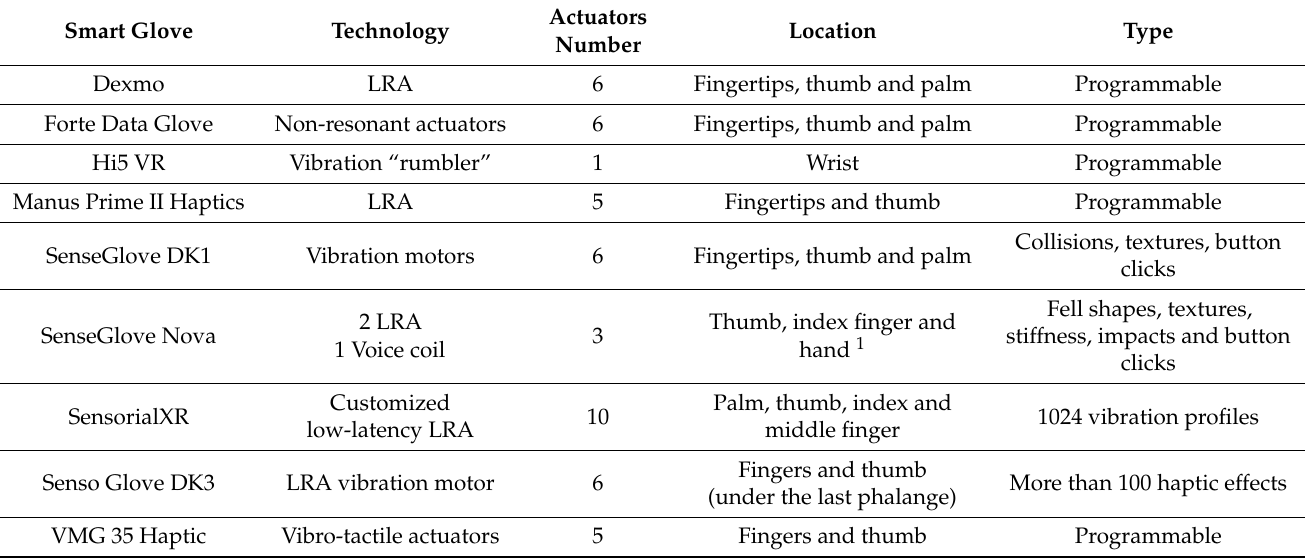
Table 7. Commercial smart gloves for tactile